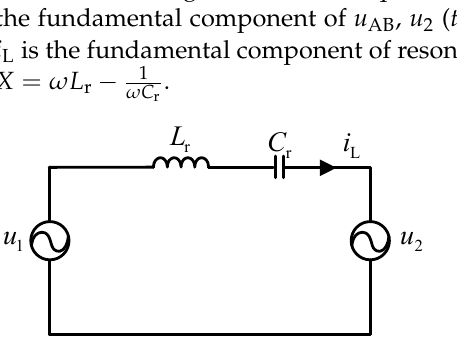
Figure 3. Work waveform under EPS modulation.